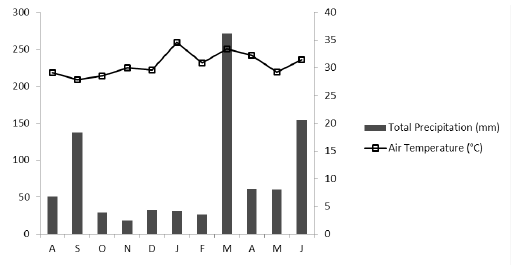
Figure 2. Total monthly rainfall (mm) and air temperature (°C) in the study area (Paraíba, Brazil).